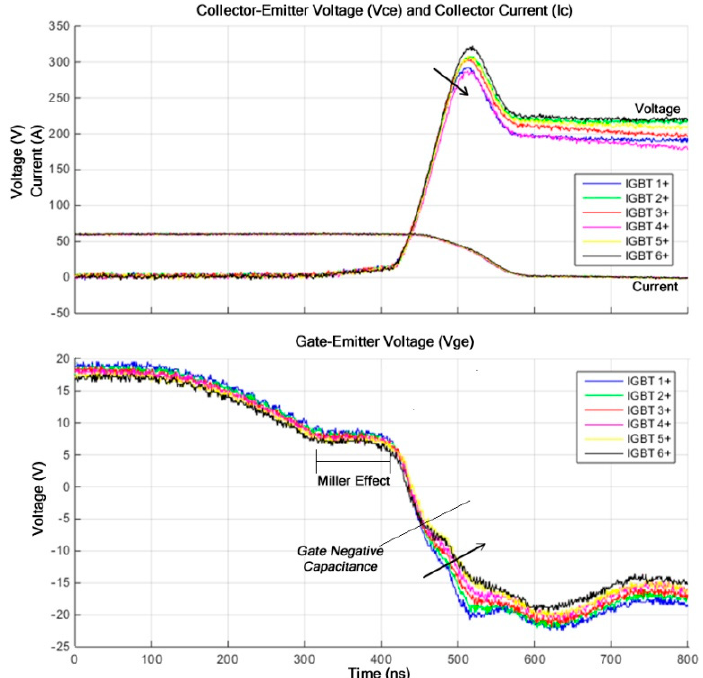
Figure 14. Turn-off switching under snubberless condition. The Vce and Vge voltages of the six series connected IGBTs are shown, as well as the collector current (Ic), with details for the Miller and negative gate capacitance effects, more apparent during the turn-off transient.